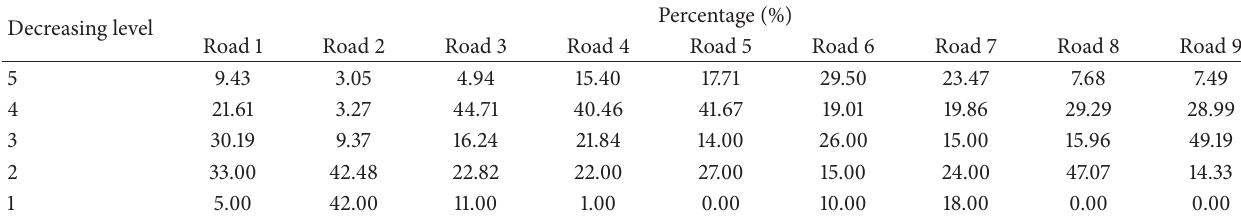
Table 10: Summary of injury accidents decreasing levels in network.